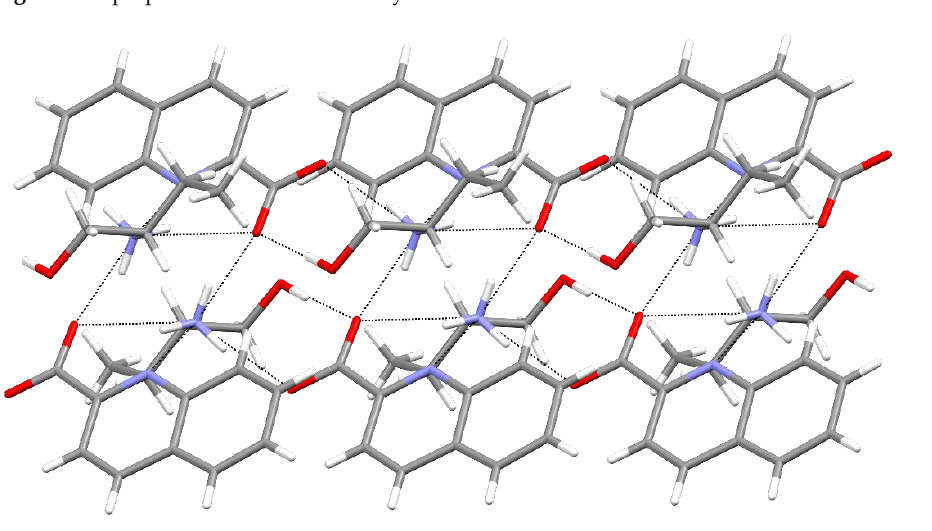
Figure 4. Section of a chain in 2b .